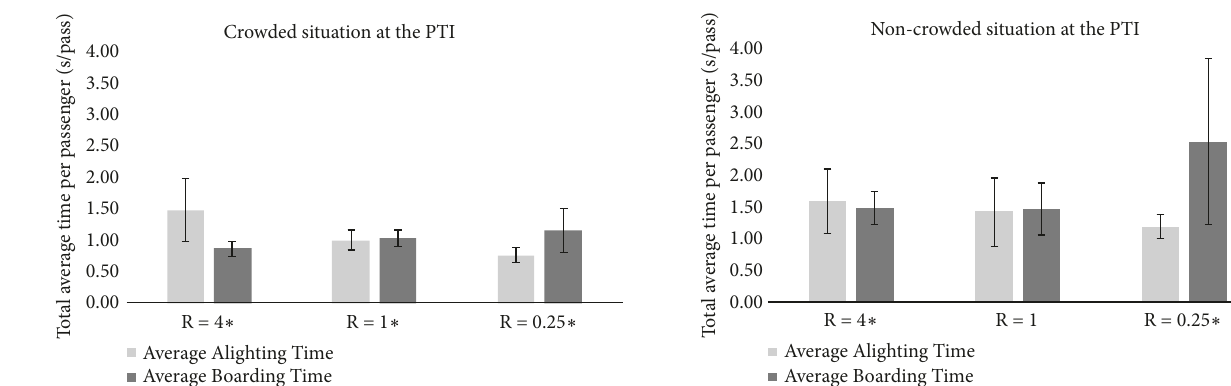
Figure 3: Total average boarding time per passenger ( 𝑡 𝑏𝑛 ) and total average alighting time per passenger ( 𝑡 𝑎𝑚 ) in crowded situations at the PTI.